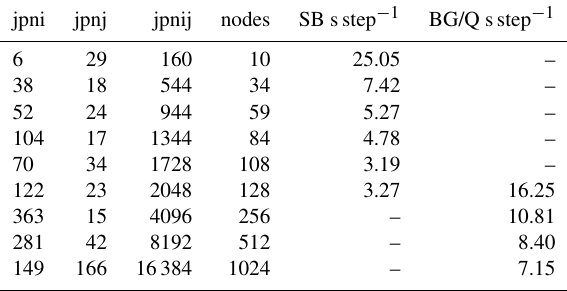
Table 2. Domain decompositions used for the experiments on the Sandy Bridge (ATHENA) and BG/Q (VESTA) architectures. The first two columns report the number of subdomains along the two horizontal directions; the third column shows the total number of processes excluding the land ones. A column follows indicating the number of nodes used to run the experiment, while the last columns show the average execution time, in s, for a time step of the simula- tion on both machines.